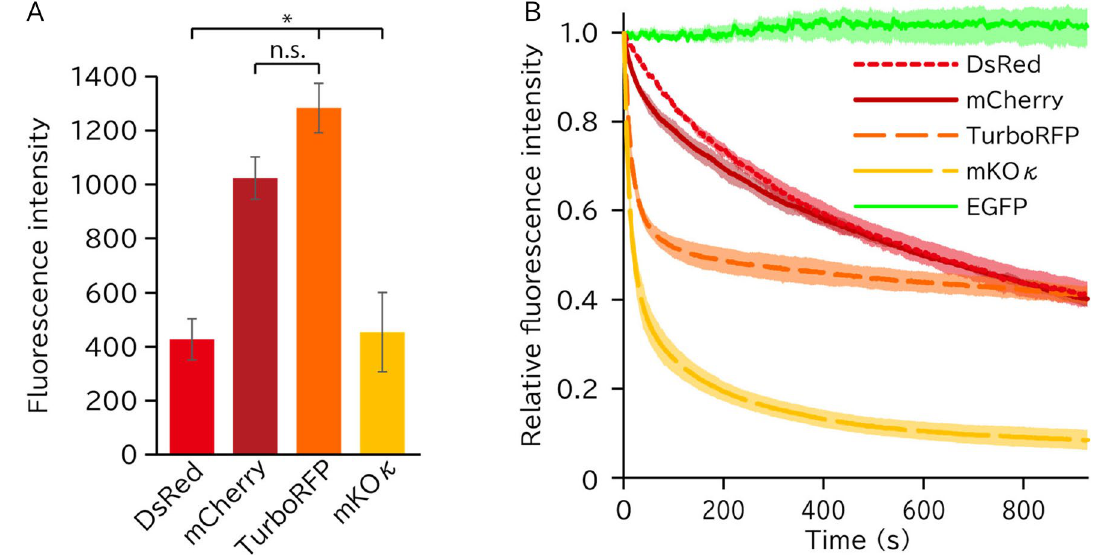
Figure 6. Brightness and photostability of the mitochondria-targeted proteins. ( A ) Average fluorescence intensity of mitochondria-targeted fluorescent proteins. n = 3 biological replicates. Each replicate included at least 80 cells from 7 visual fields. n.s.: not significant (p > 0.05); Tukey’s HSD test. ( B ) Photobleaching of fluorescent proteins in iAECs during confocal imaging with a 488 nm (for EGFP) or a 555 nm (for other fluorescent proteins) excitation laser. The data are the average of at least three cells. Shaded areas indicate ±